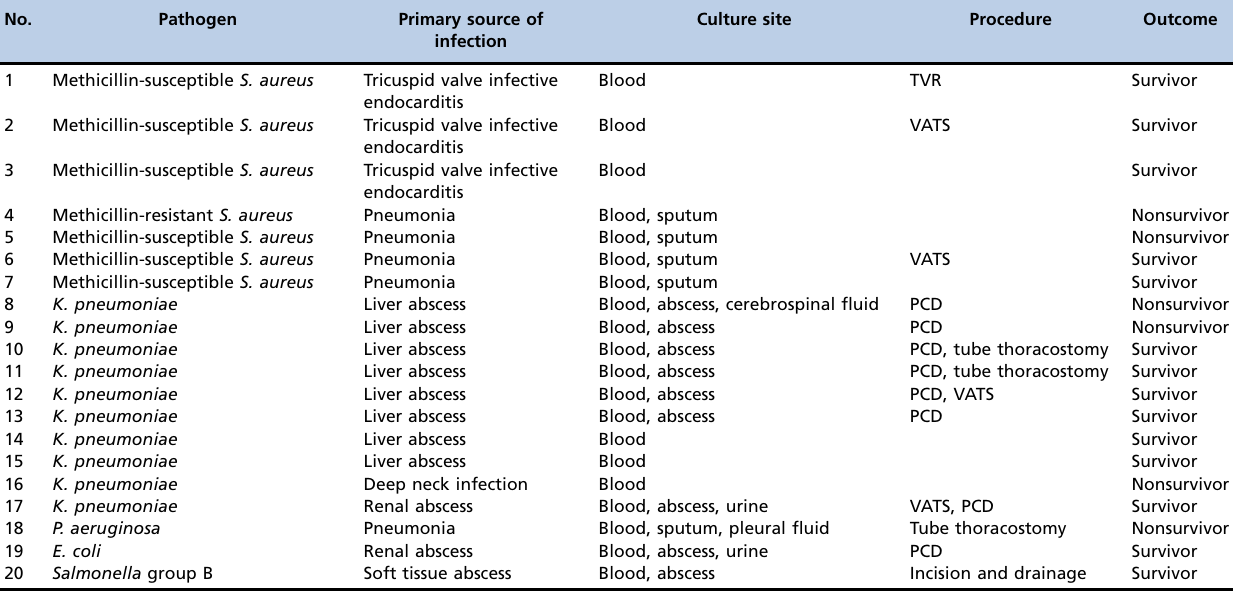
Table 2 - Causative pathogens, primary sources of infection, and surgical procedures for the 20 patients